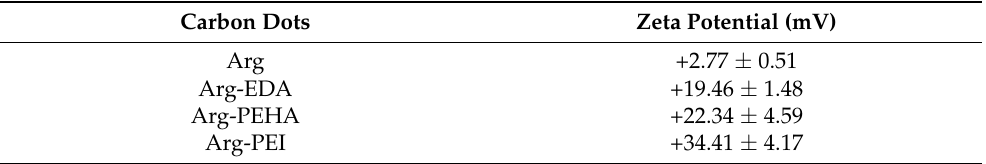
Table 1. Zeta potential values of arginine CDs and its amine-modified forms with different amine sources.